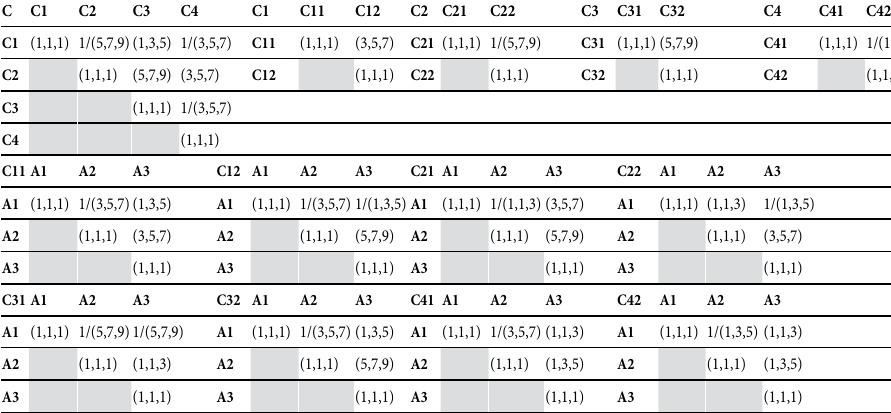
Table 4. Triangular fuzzy numbers for linguistic variables